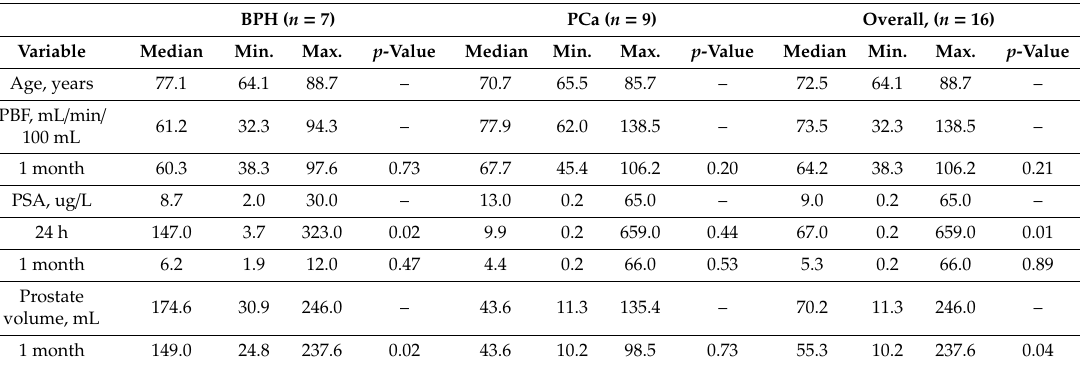
Table 1. Baseline and follow-up